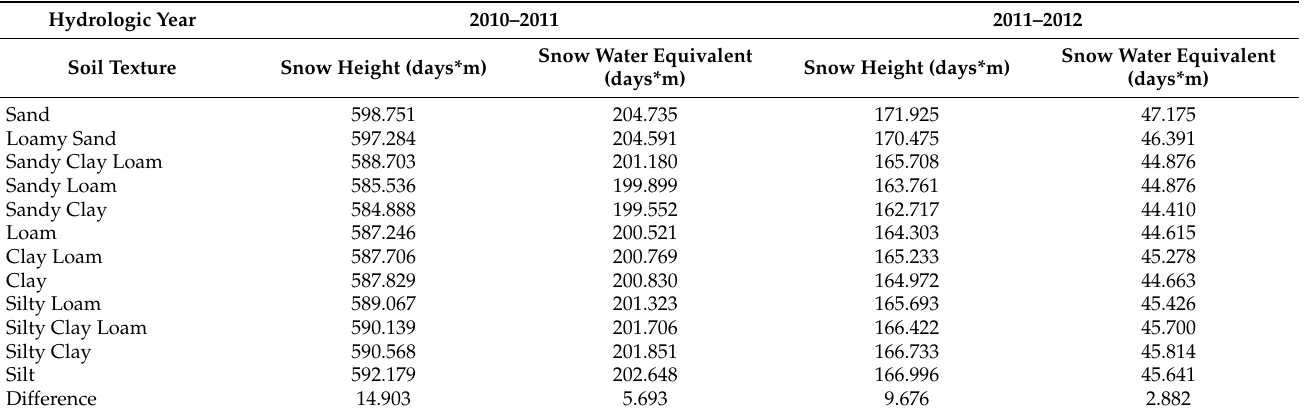
Table 2. Snow height and snow water equivalent (SWE) areas for both hydrologic years and all